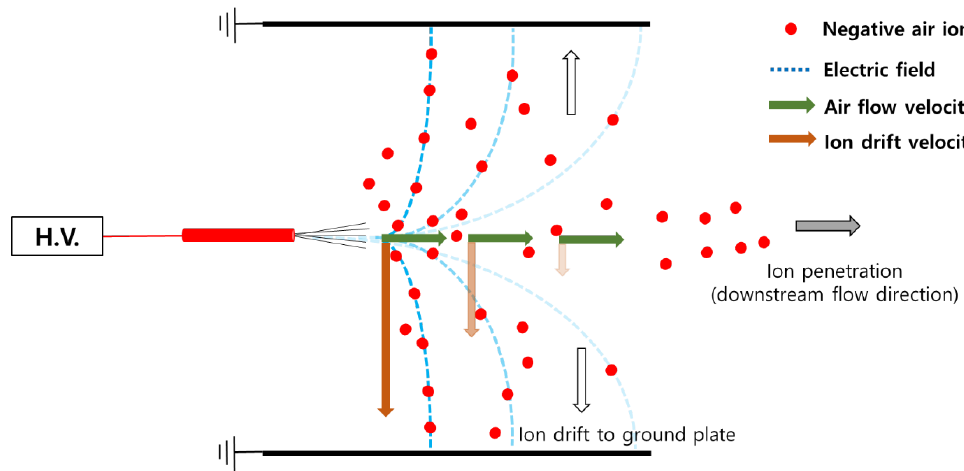
Figure 6. Movement path of negative ions generated inside the ionizing channel used.